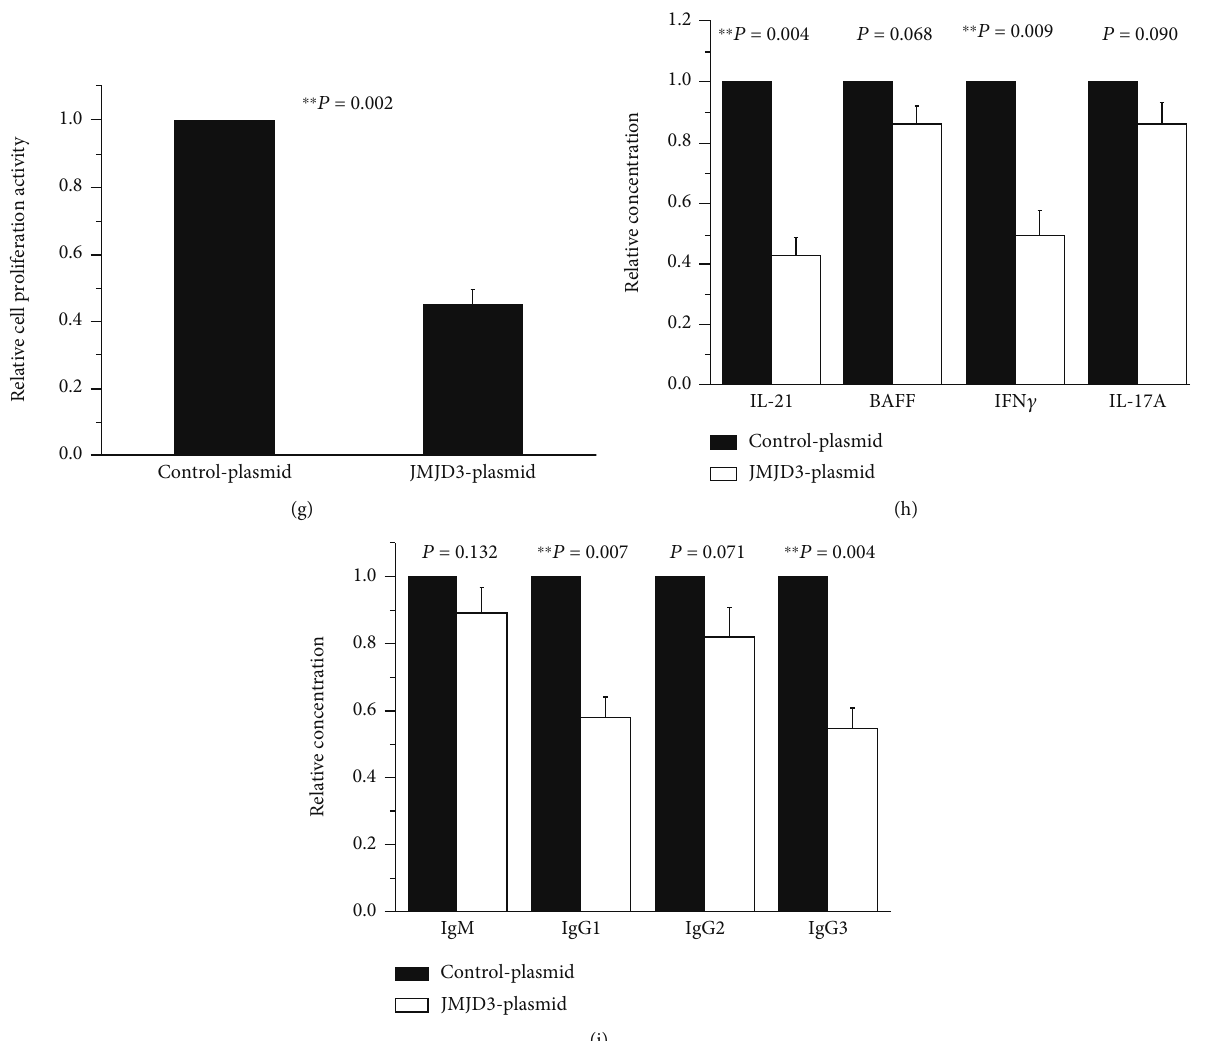
Figure 4: E ff ects of JMJD3 upregulation on Tfh cells from 3 SLE patients. (a, b) Relative JMJD3 and HPK1 protein levels in SLE Tfh cells transfected with pcDNA3.1 blank plasmid or pcDNA3.1-JMJD3-expressing plasmid were measured by western blot analysis after stimulation. β -Actin was used as endogenous control. (c – f) Relative JMJD3 (c), H3K27me3 (d), H3K4me3 (e), MLL1, MLL2, MLL3, and MLL4 (f) enrichments at the HPK1 promoter in SLE Tfh cells transfected with pcDNA3.1 blank plasmid or